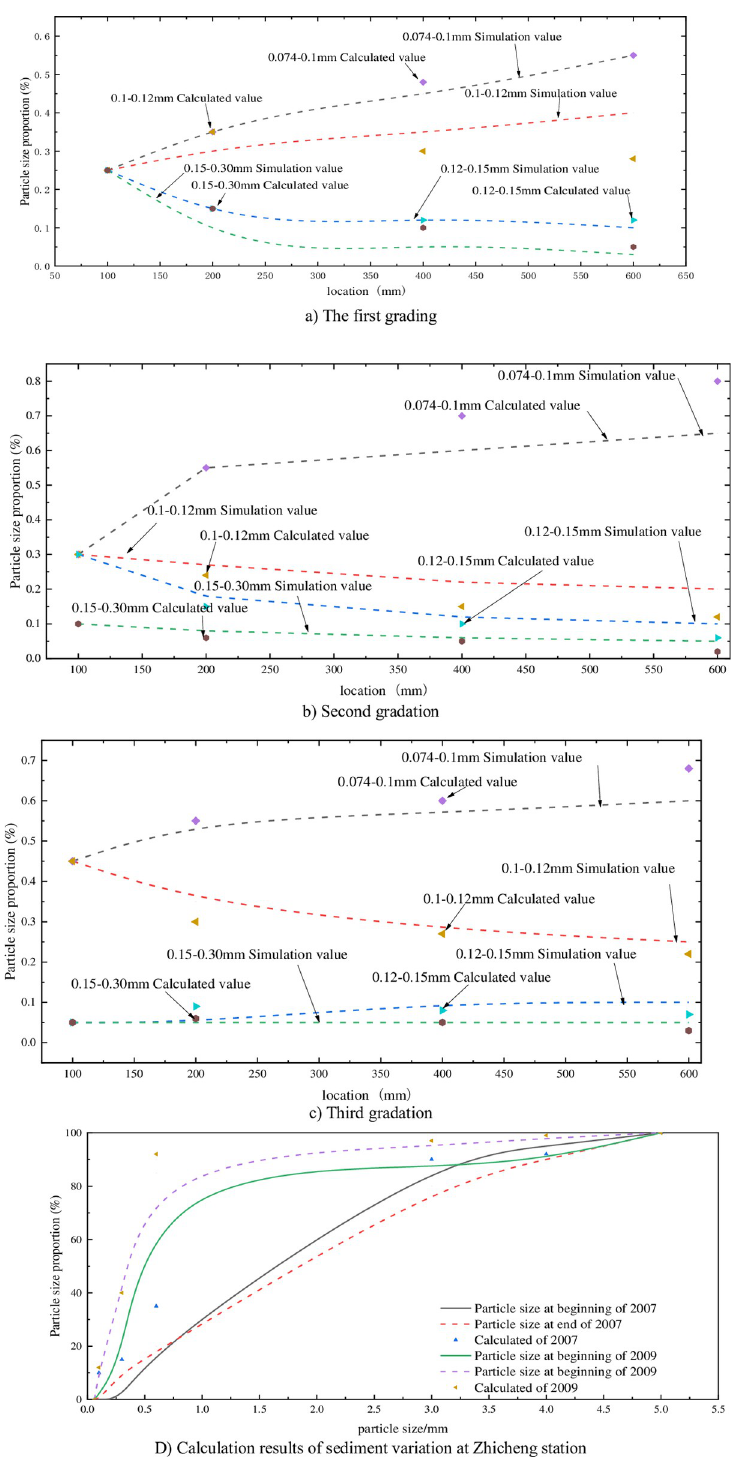
Fig 7. Analysis diagram of analog and computational gradation distribution. a) The first grading, b) Second gradation, c) Third gradation, D) Calculation results of sediment variation at Zhicheng station.